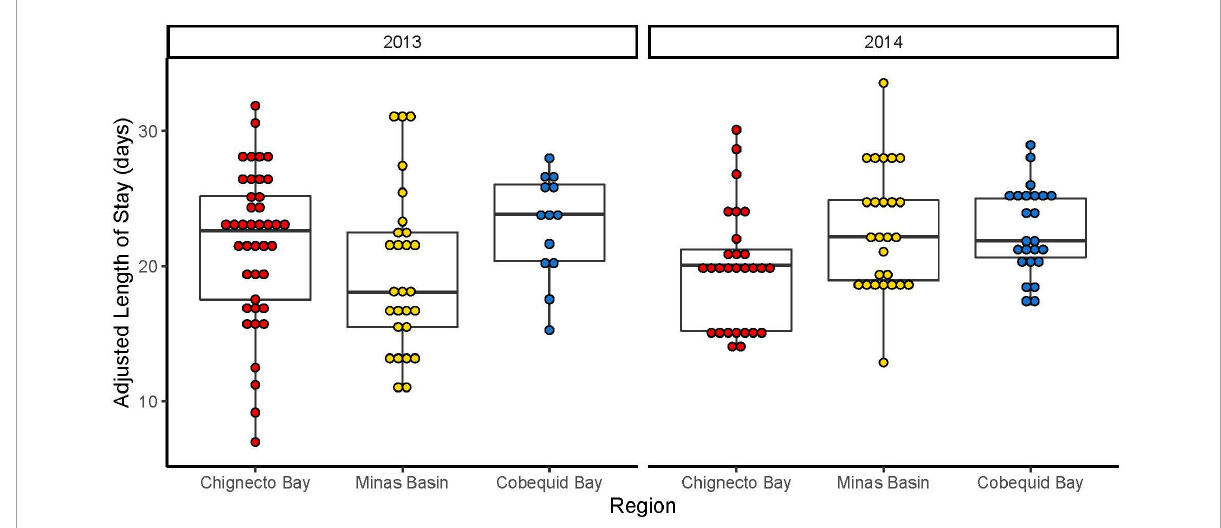
FIGURE3 Adjusted length of stay (controlling for date of capture and relative fuel load) of Semipalmated Sandpipers using separate regions (Chignecto Bay, Cobequid Bay, and Minas Basin) of the Bay of Fundy in 2013 and 2014. Boxes represent the median (midline) and first and third quartile (ends). Details of capture timing are provided in Neima et al. (2020) and Supplementary Figure 1